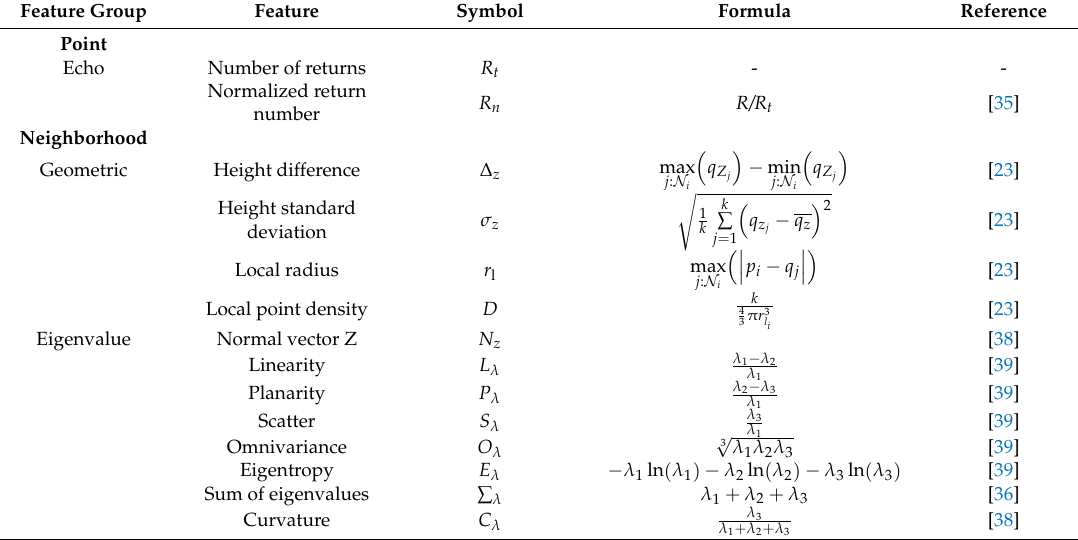
Table 1. Overview of point-based and neighborhood-based features used in the vegetation classification. The point-based features are based only on return number information stored with each point (i.e., echo information) whereas neighborhood-based features are based on the local geometry and eigenvalue characteristics derived from the x, y and z coordinates of the point